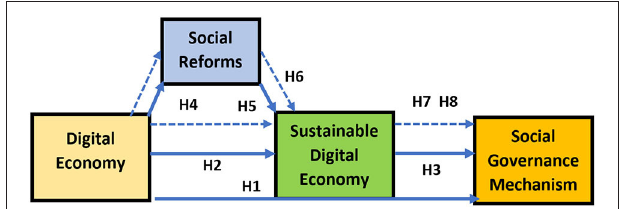
FIGURE 1 | Theoretical